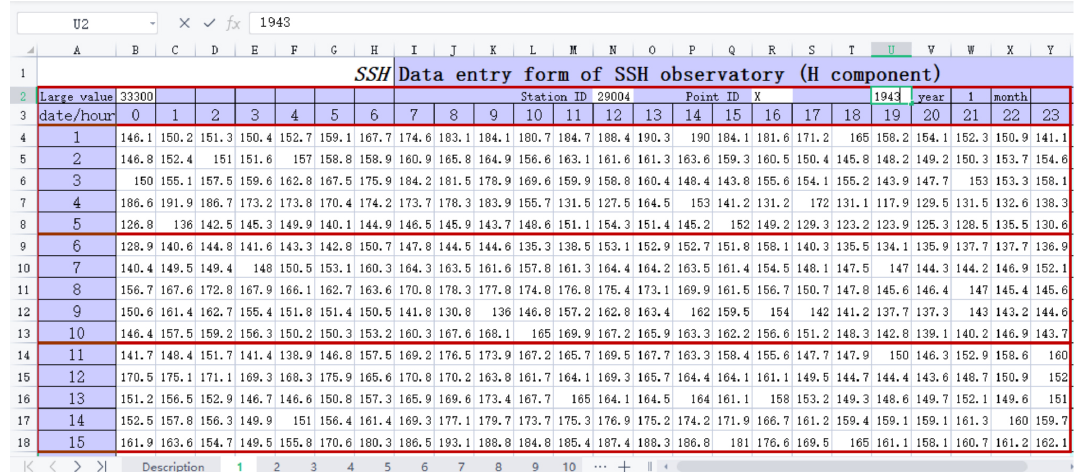
Figure 2. An example of the Excel tables with digitized data.